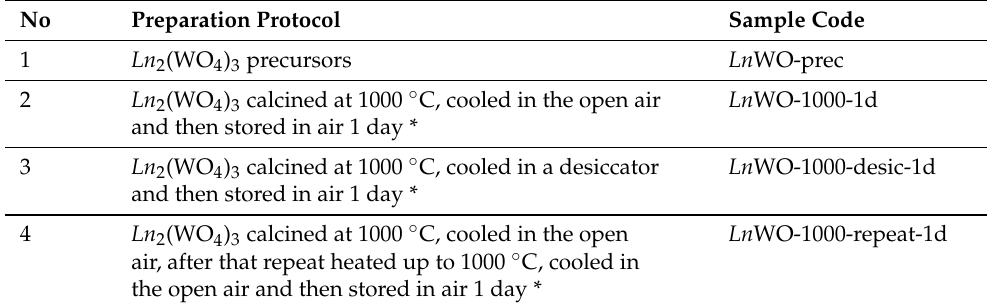
Table 1. Synthesis conditions and symbols for Ln 2 (WO 4 ) 3